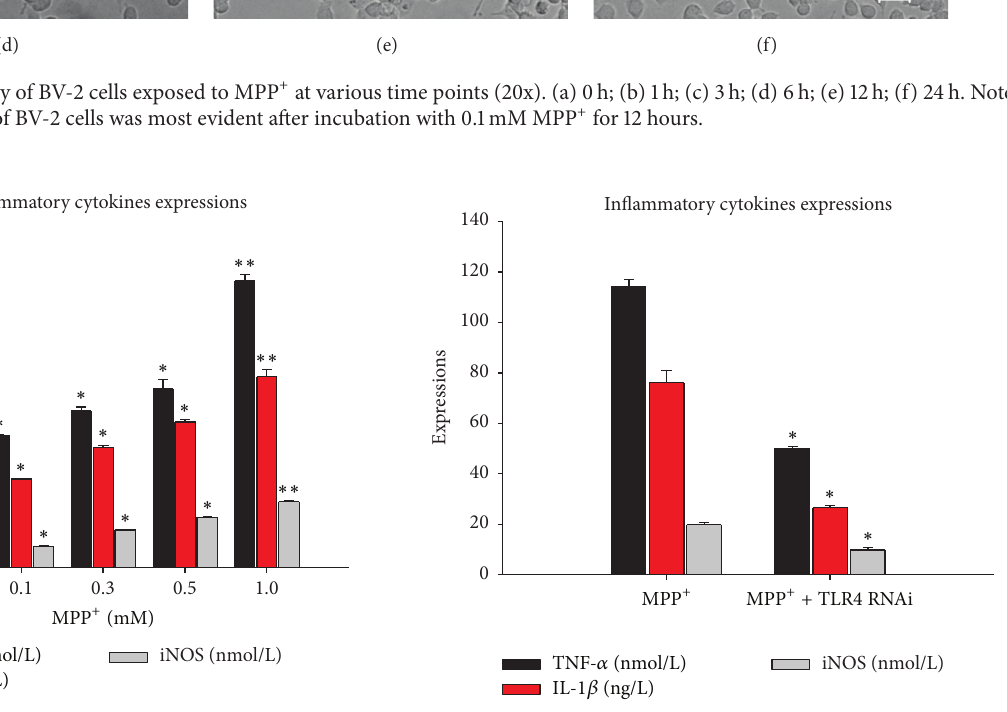
Figure 4: The changes of TNF- 𝛼 , IL-1 𝛽 , and iNOS in TLR4 siRNA treated BV-2 cells after exposure to MPP + for 12h. Note that, after the treatment with TLR4 siRNA interference, the levels of TNF- 𝛼 , IL-1 𝛽 , and iNOS were statistically decreased in the 0.1mM MPP + group as compared with those of 0.1 mM MPP + group without the treatment with TLR4 siRNA interference. ∗ 𝑃 < 0.05